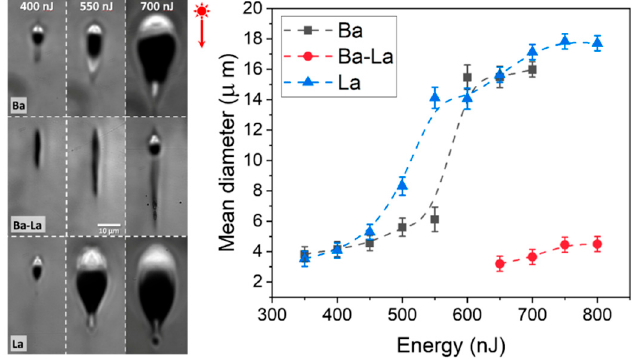
Figure 2. ( Left panel) Transmission optical microscopy images of the cross section of structures produced in Ba-, Ba-La-and La-samples at the indicated writing pulse energies. ( Right plot) Mean diameter of the structures produced in the three different composition samples as a function of the writing pulse energy.